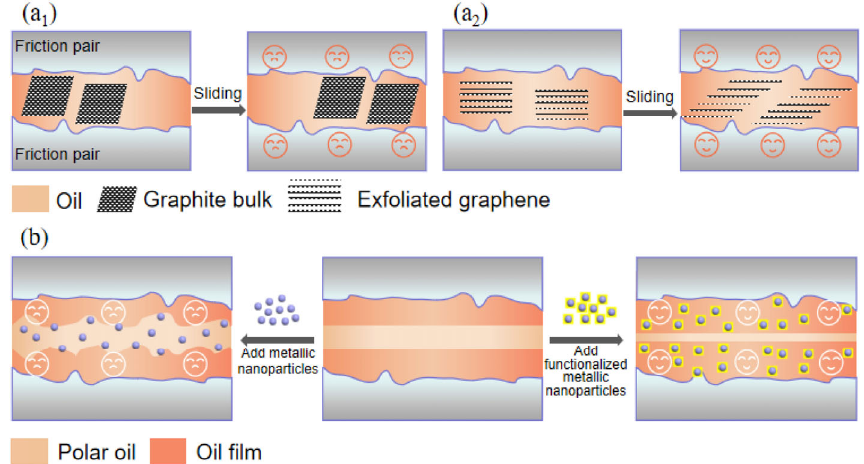
Fig. 15 Diagram of